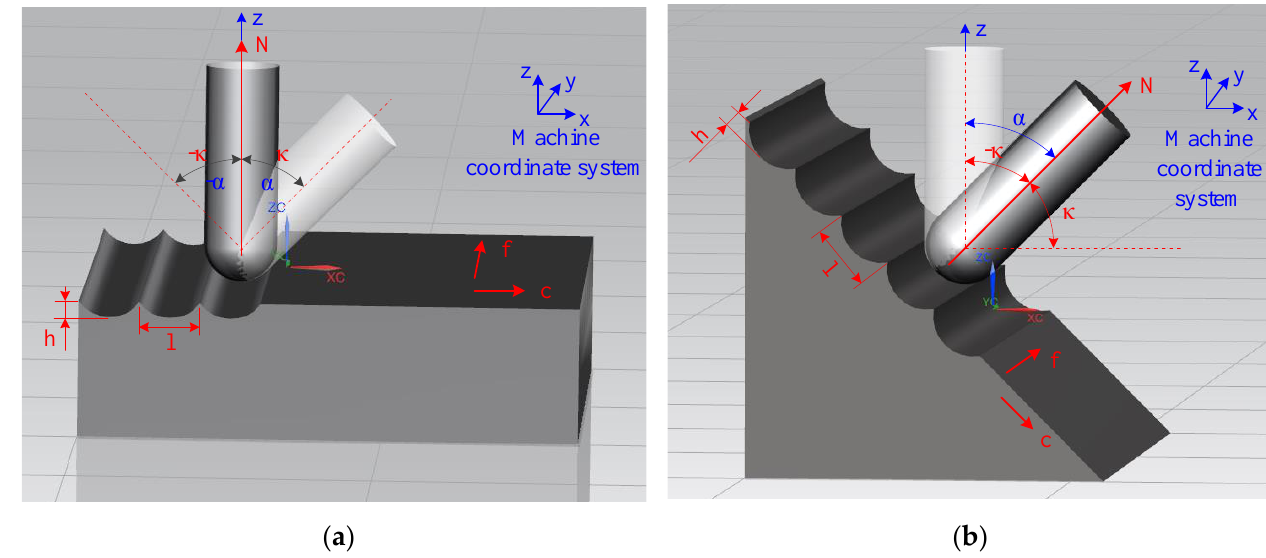
Figure 5. B-axis deflection angle α and tool tilt angle κ in ( a ) plane milling and ( b ) bevel milling.